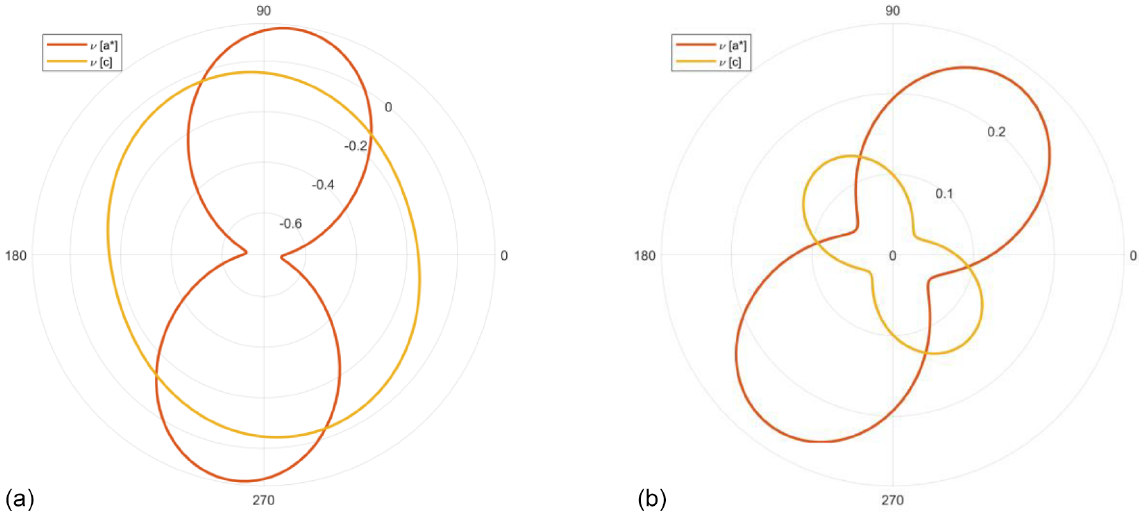
Figure A7. Benchmarks to Mainprice et al. (2008, their Fig. 5) for triclinic talc (c1) at 0.0GPa (a) and 3.9GPa (b) . The lower-pressure example shows auxetic